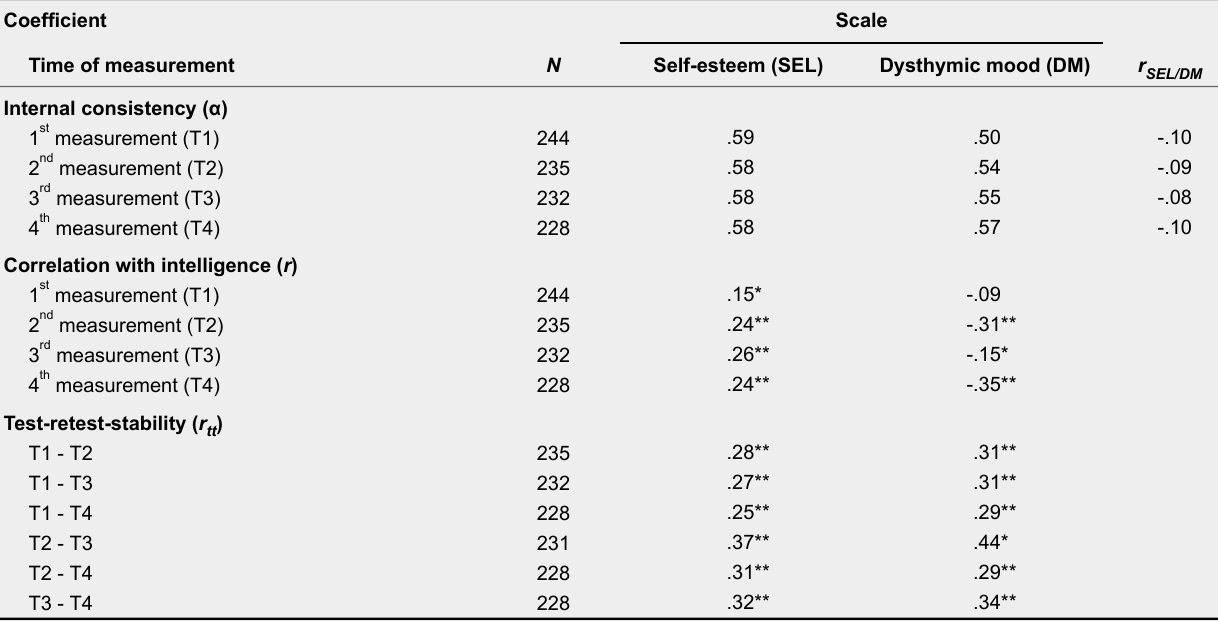
Coefficients of Internal Consistency (Cronbach’s α), Intercorrelations and Correlations With Intelligence of Self-Esteem and Dysthymic Mood at the Four Times of Measurement as Well as Coefficients of Test-Retest Stability Between the Four Times of Measurement in the